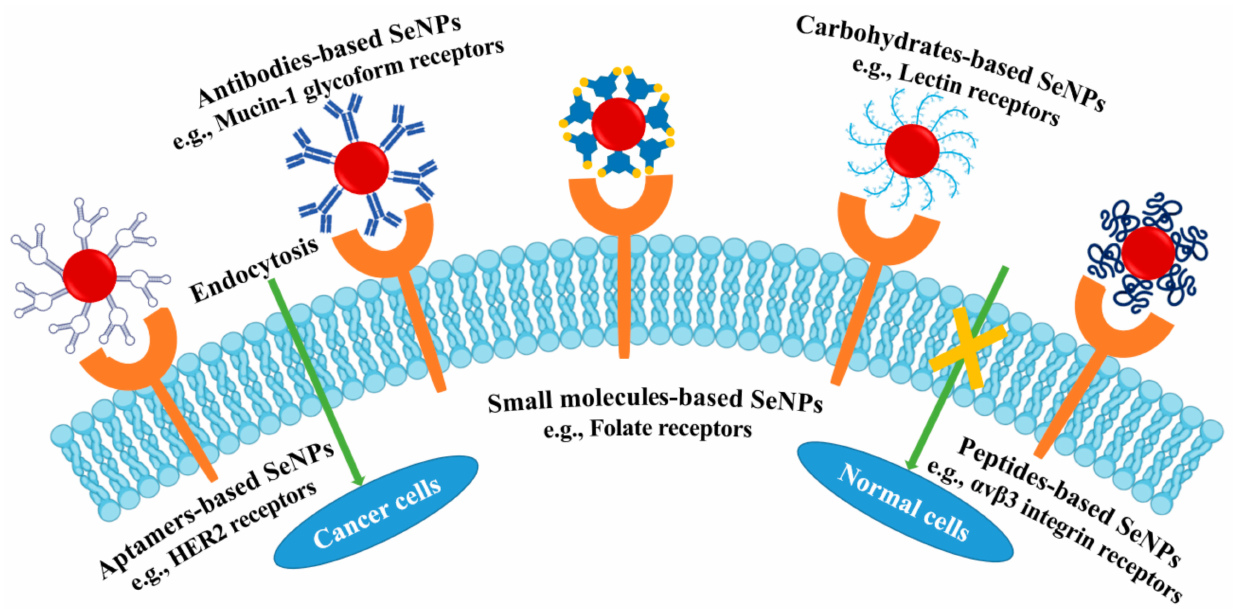
Figure 6. Various targeting ligands functionalized